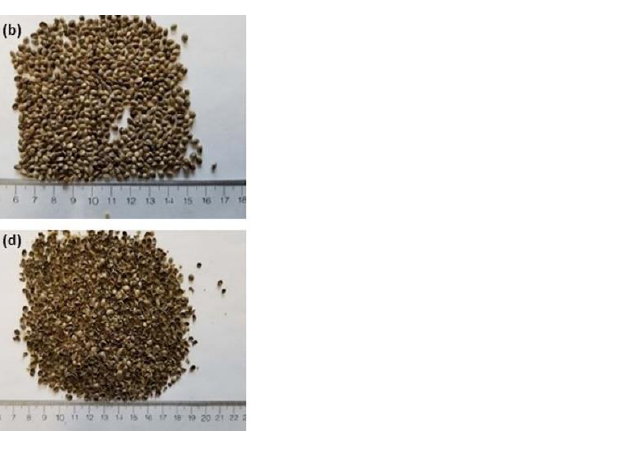
Figure 1. Research material. ( a ) hemp hearts, ( b ) whole hemp seeds, ( c ) hemp cakes and ( d ) hemp seed